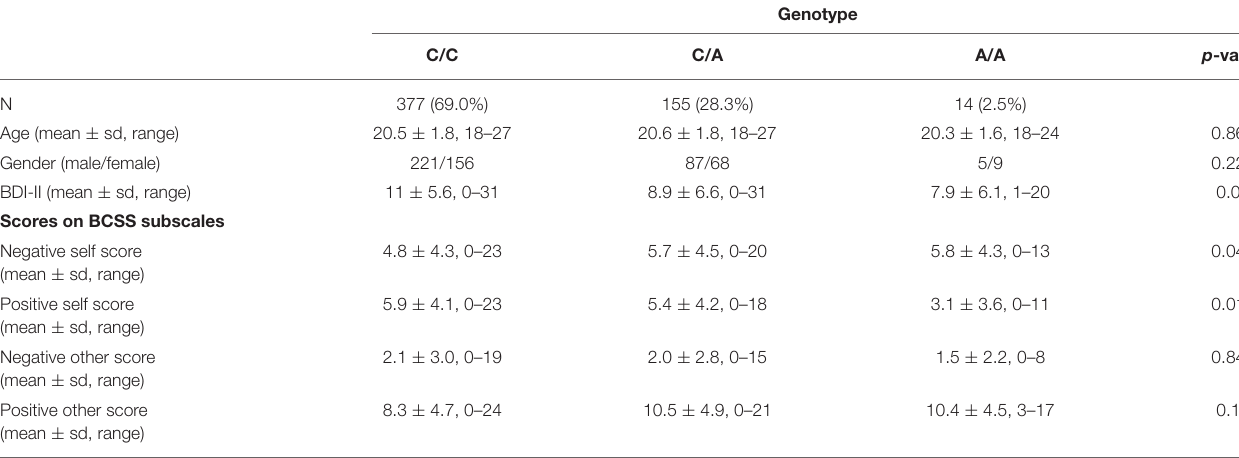
TABLE 2 | The demographics of subjects subdivided according to OLIG2 genotype.